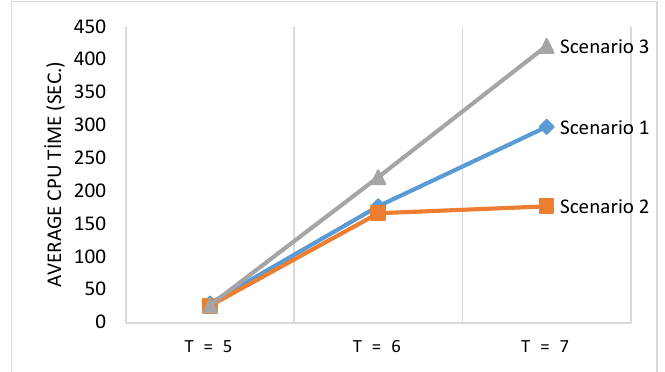
Fig. 5. Effect of 𝑇 on the average CPU times for 𝑉 = 3 (MILP-C model)